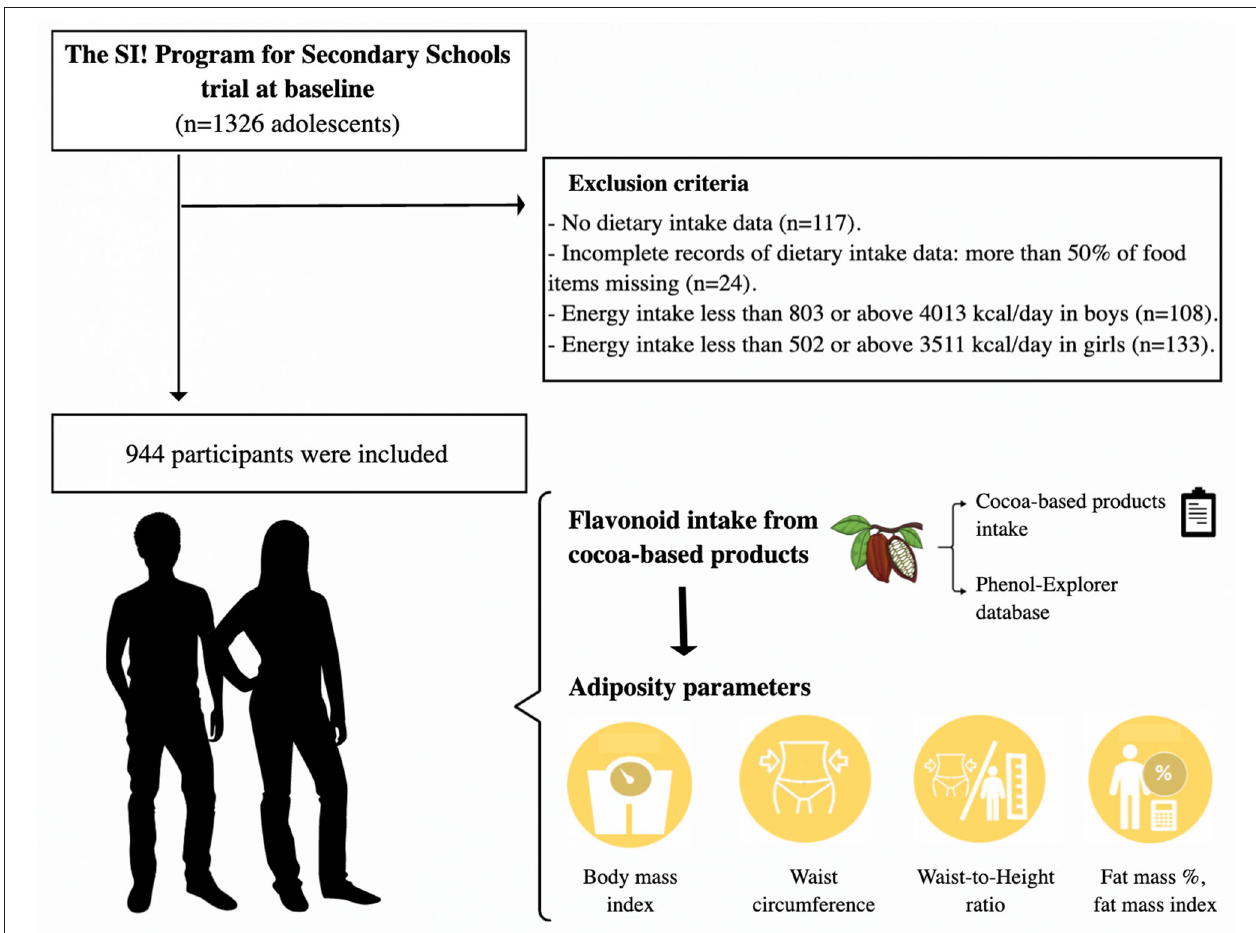
FIGURE 1 | Study design of the